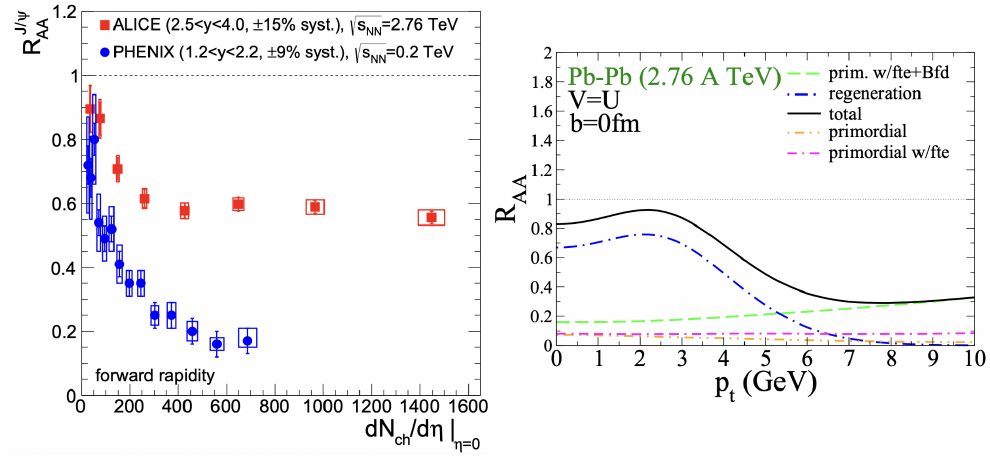
Figure 4. ( Left ): The J / ψ nuclear modification factor as a function of multiplicity density at forward rapidity in A + A collisions [29]. The blue (red) data points correspond to the PHENIX [30] (ALICE [31]) measurements. Reprinted with permission from World Scientific. ( Right ): Theoretical predictions for the contribution to the total nuclear modification factor due to regeneration in Pb + Pb collisions at the LHC [32] as a function of transverse momentum. Reprinted with permission from